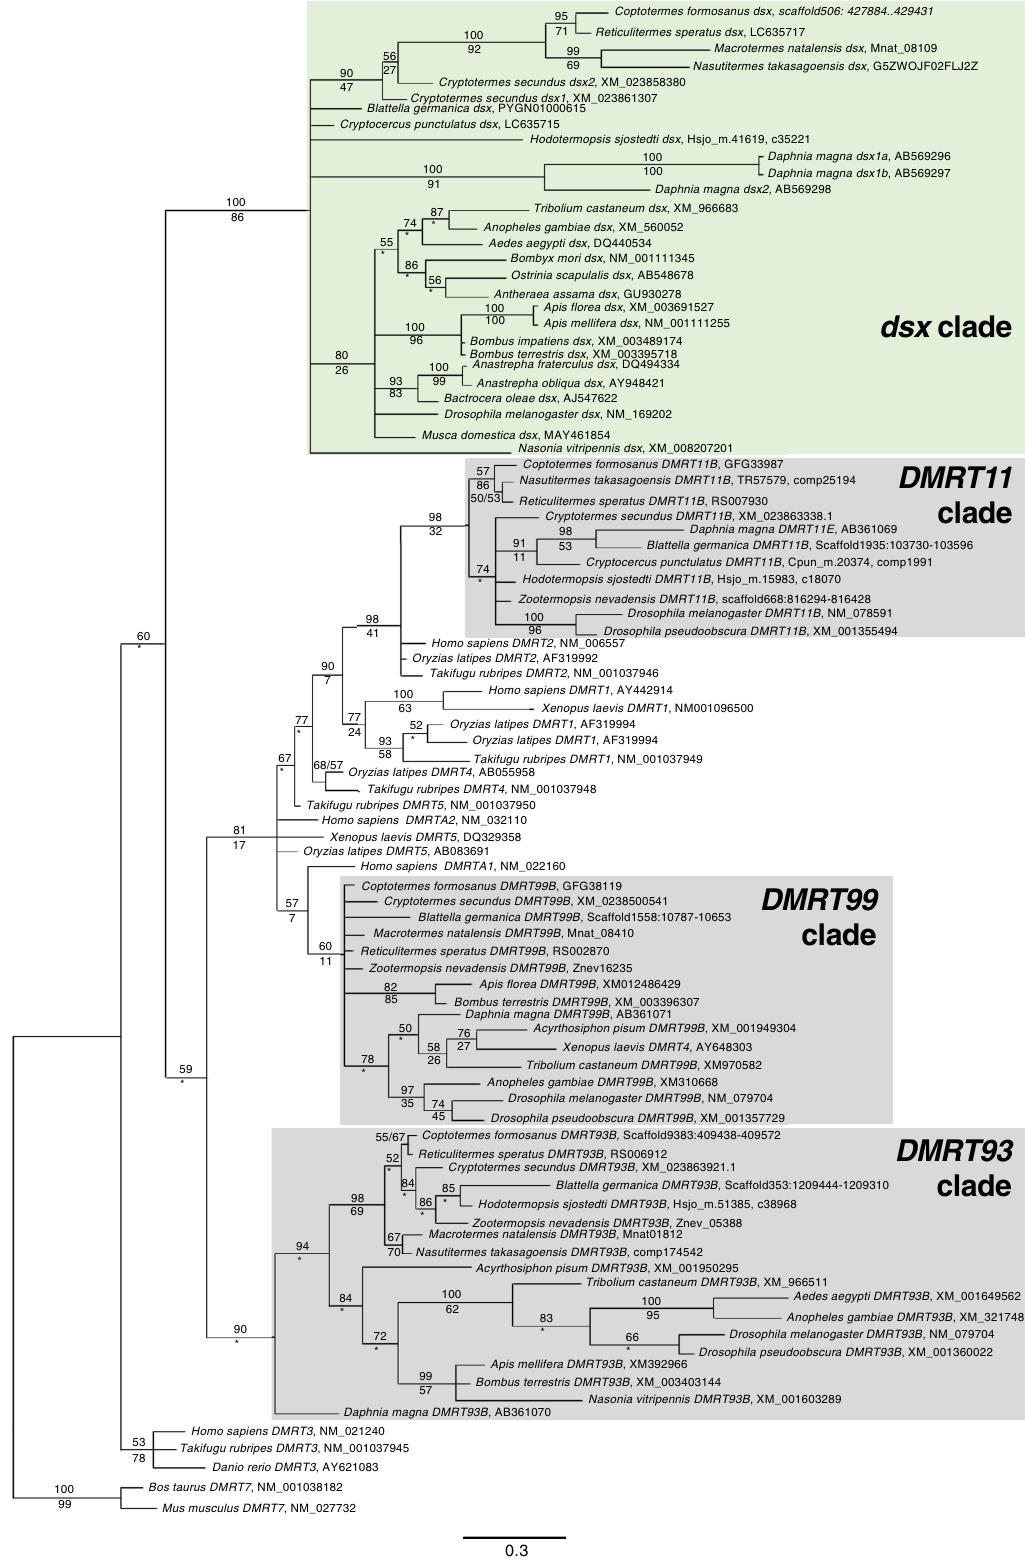
Figure 2. Molecular phylogenetic tree of dsx and DMRT homologues. Bayesian tree of dsx and DMRT of insects and crustaceans was constructed based on the OD1 sequences (135 bp with no gaps). Numbers shown above branches represent the Bayes posterior probabilities. Bootstrap values (1000 replicates) are shown below branches to indicate the level of support in the ML method. An asterisk indicates that a node is not supported by the ML